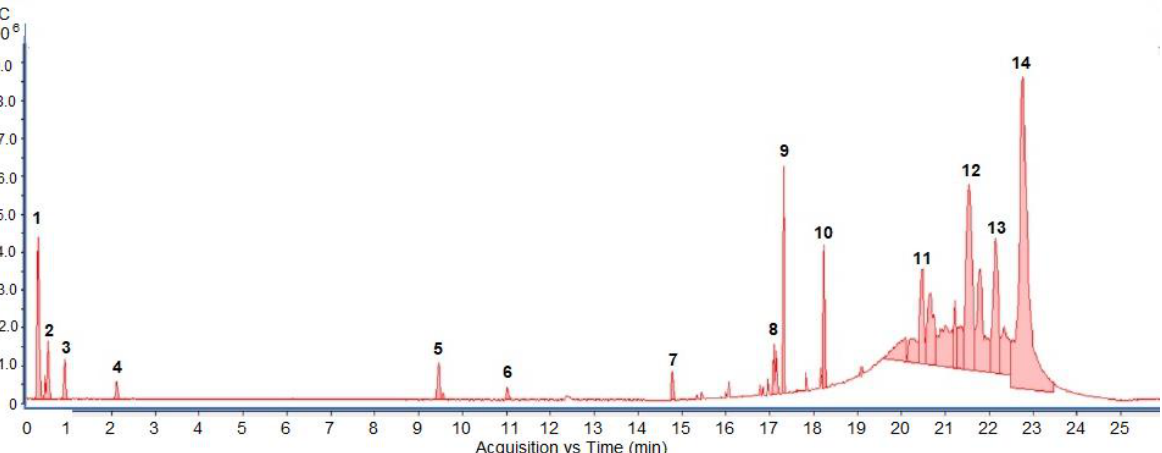
Figure 1. UHPLC – ESI-QTOF-MS/MS extracted ion chromatogram produced from 50% ethanolic ex- Figure 1. UHPLC–ESI-QTOF-MS/MS extracted ion chromatogram produced from 50% ethanolic extract tract of P. odoratum Lour . cv. Pakphai leaves at the selected deprotonated molecules [M — H] − . Ab- of P. odoratum Lour. cv. Pakphai leaves at the selected deprotonated molecules [M—H] − . Abbreviations: breviations: TIC = total ion counts, UHPLC-ESI-QTOF-MS/MS = ultrahigh-performance liquid chro- TIC = total ion counts, UHPLC-ESI-QTOF-MS/MS = ultrahigh-performance liquid matography – electrospray ionization-quadrupole time-of-flight-mass spectrometry/mass spectrom- etry. Table 1. UHPLC – ESI-QTOF-MS/MS identification of phenolic compounds in 50% ethanolic extract of P. odoratum Lour . cv. Pakphai leaves.